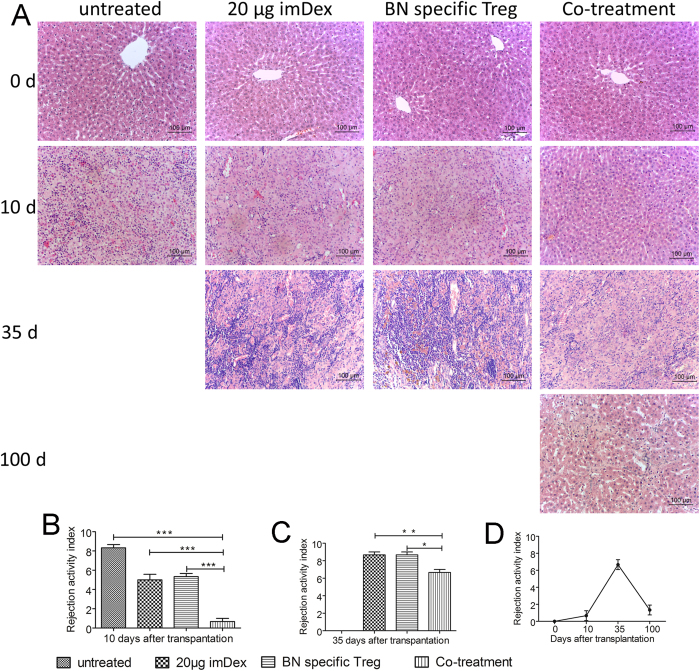
Pathology of rat liver grafts in each group (magnification: ×200).(A) On the 10th, 35th and 100th days after liver transplantation, three recipient grafts were harvested in each group and stained with HE for pathological analysis (8 × 200 fields per slide and 3 slides per animal. Representative fields are shown in A). Due to the relatively short survival times, grafts from some groups are not shown for the 35 and 100 day analyses. Bars represent 100 μm. (B) Analysis of RAI among the 10-day grafts. (C) Analysis of RAI among the 35-day grafts. (D) RAI analysis among the co-treatment group grafts on the 10th, 35th and 100th day after liver transplantation. *Indicates p < 0.05; **indicates p < 0.01; ***indicates p < 0.001.